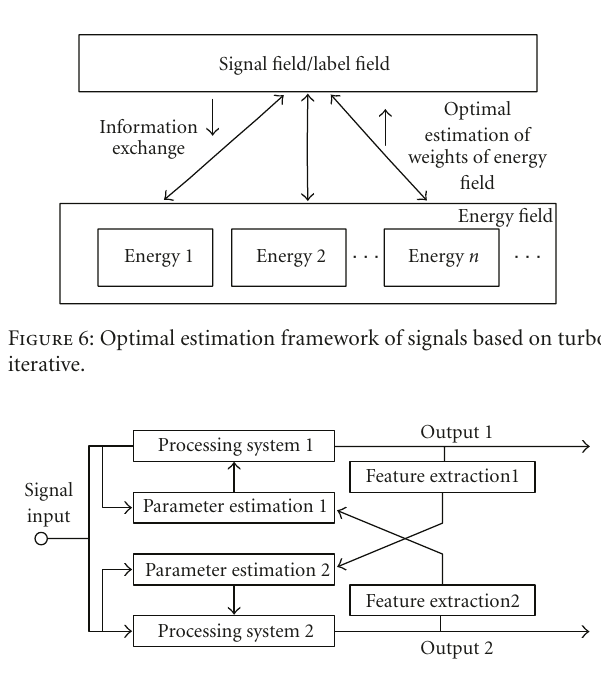
Figure 7: Turbo iterative